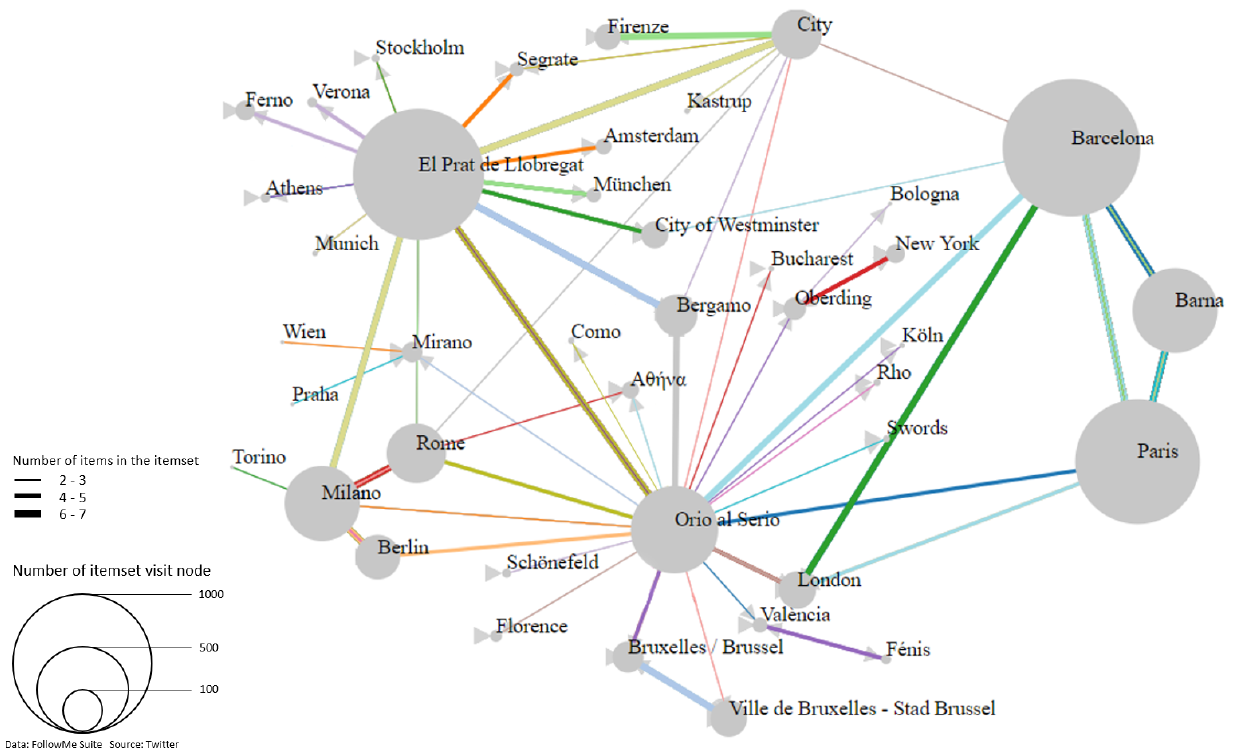
Figure 11. Topological representation for discovered itemsets from the large data set by applying Interpretation